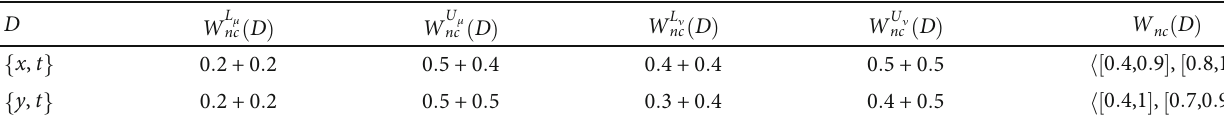
Table 3: Calculating the weight of SISs.